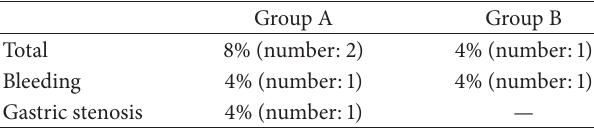
Table 2: Postoperatory